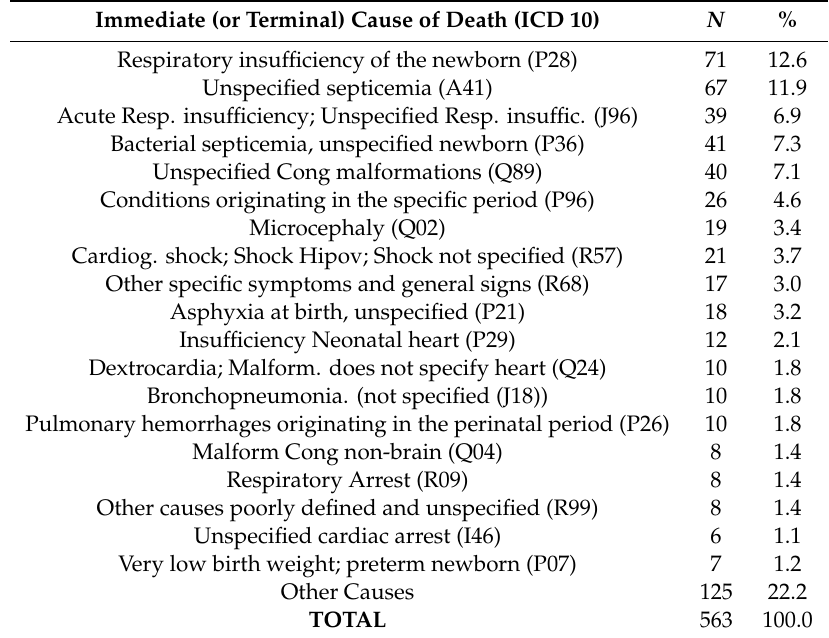
Table 1. Number and percentage of deaths of children with microcephaly / congenital Zika syndrome (confirmed and possible a ), according to the immediate cause. Brazil,